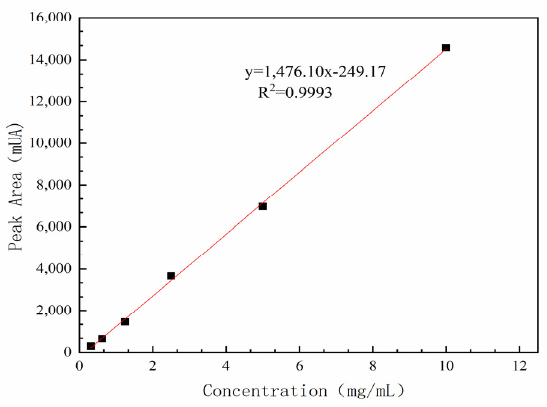
Figure 2. Standard curve of standard C. oleifera saponins by liquid chromatography. Precision Test